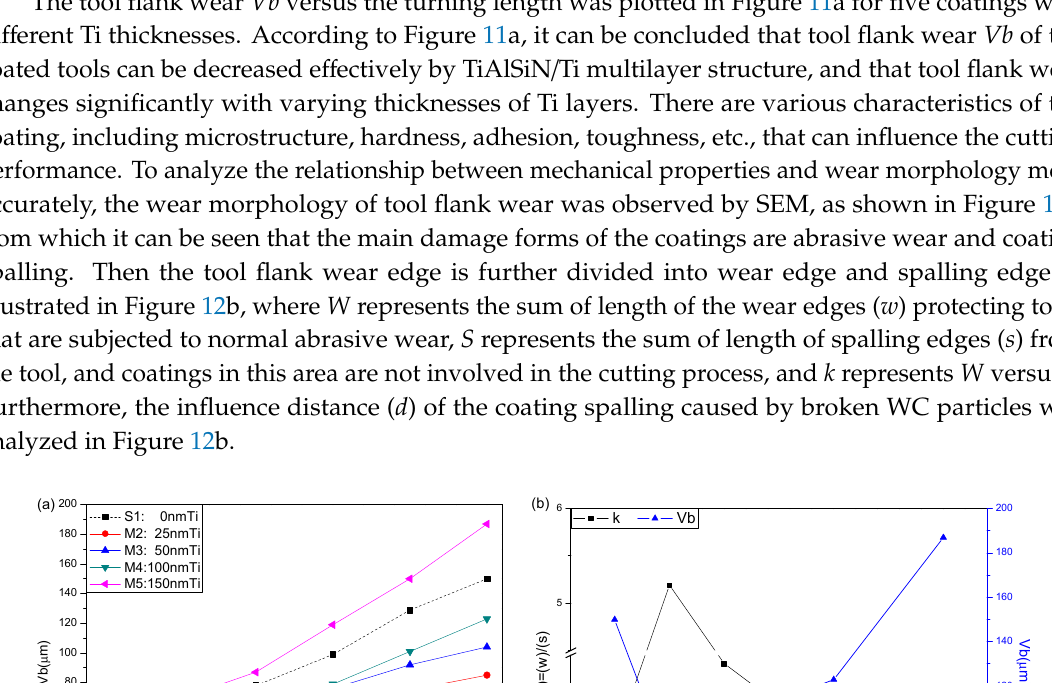
(cid:80) (cid:80) ( w ) / ( s